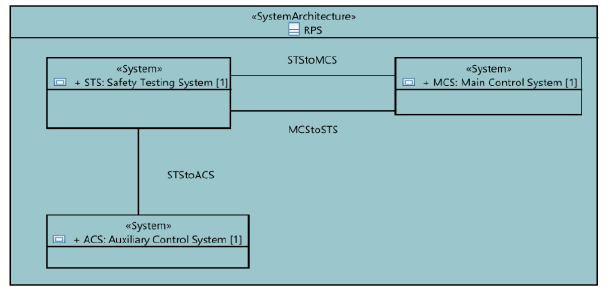
Fig.4- Communications between the RPS’ sub-systems.